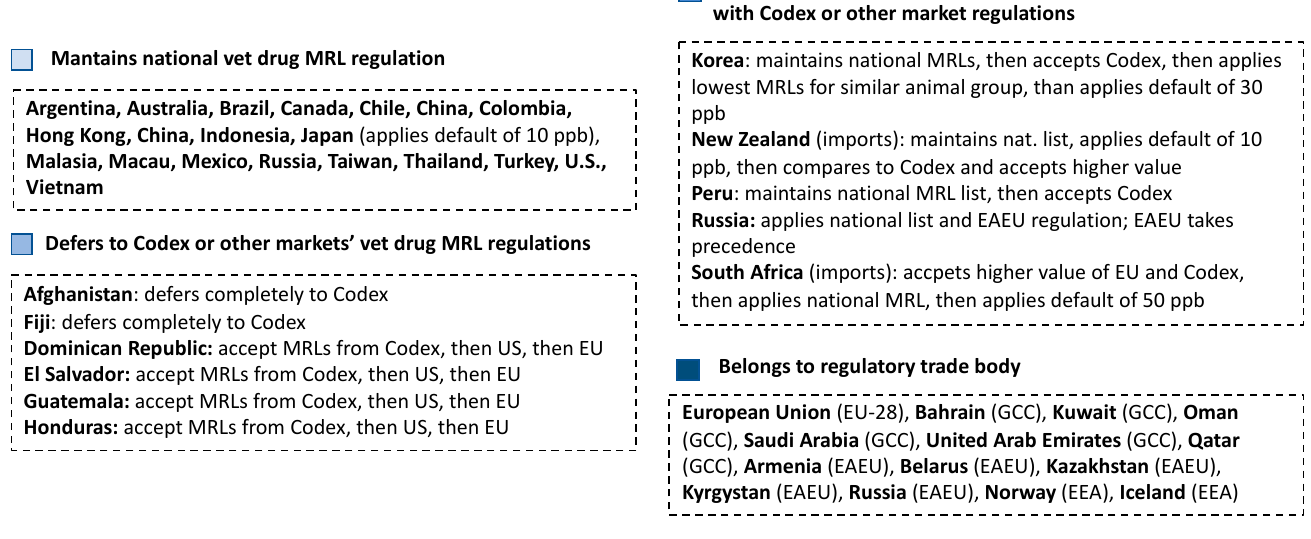
Figure 1. Veterinary drug MRL regulations used in countries around the globe. Adapted from the article “Veterinary Drug MRLs—A Global Perspective, by Ann Stevenson, Manager, Regulatory Data. Bryant Christie Inc”. European Union (EU), European Economic Area (EEA), Gulf Cooperation Council (GCC), Eurasian Economic Union (EAEU).